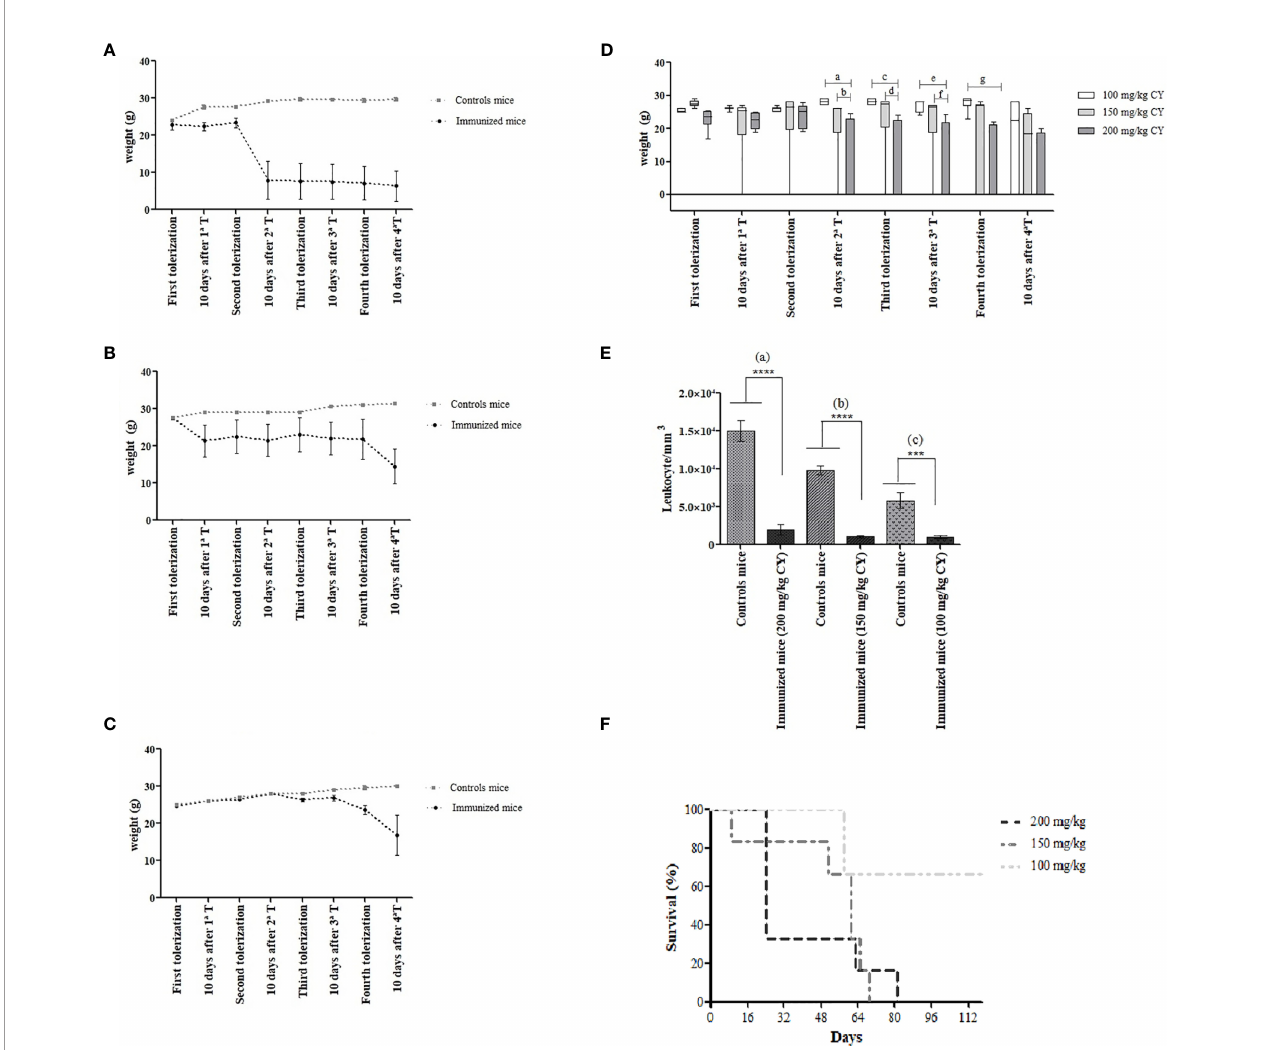
FIGURE 1 | Body weight changes in BALB/c mice during MTSI protocol using (A) 200 mg/kg BW of CY, (B) 150 mg/kg BW of CY and (C) 100 mg/kg BW of CY. The weight was measured at the start of each tolerization cycle and ten days after the last administered dose of CY (48 hours). Box diagram showing the statistically signi fi cant differences of body weight during the immunization of mice using different concentrations of cyclophosphamide. Statistical analysis was performed using One Way ANOVA test with Sidak ’ s post test and multiple comparisons. a p= (0.0004); b p= 0.221; c p= 0.0003; d p= 0.0085; e p= 0.0007, f p= 0.0142, g p= 0.0003 (D) . Survival analysis shows the death of 100% of mice that were treated with higher doses of CY (E) . Leukocyte counts/mm 3 of the immunized mice were compared with the leukocyte counts of the non-immune mice (200 mg/kg and 150 mg/kg; p < 0.0001), (100 mg/kg; p = 0.0002) (F) . ****means p < 0.0001;***means p =